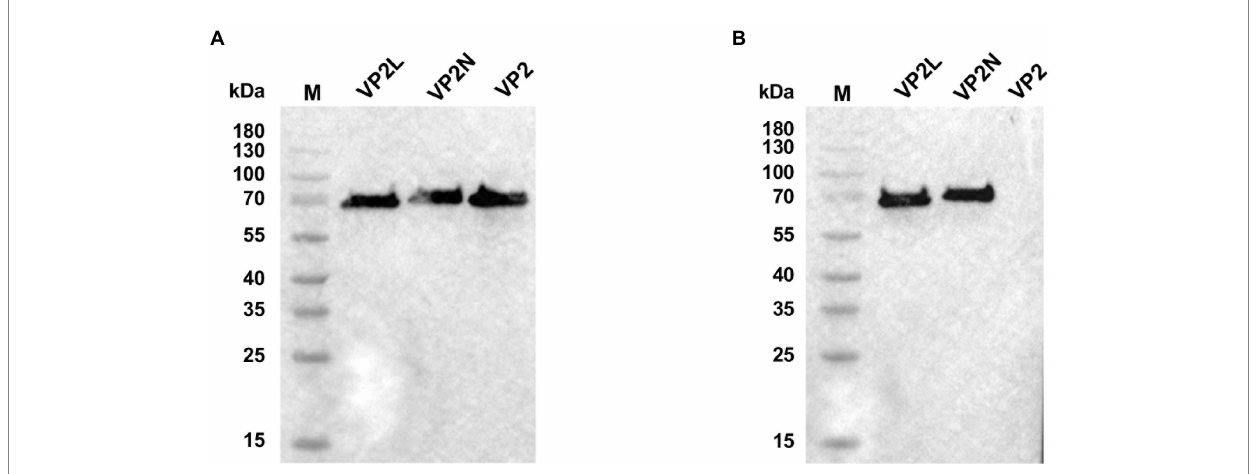
FIGURE 3 Western blot analysis of recombinant proteins of CPV VP2/VP2N/VP2L. (A) Using an anti-CPV monoclonal antibody as the primary antibody; (B) using an anti-CDV monoclonal antibody as the primary